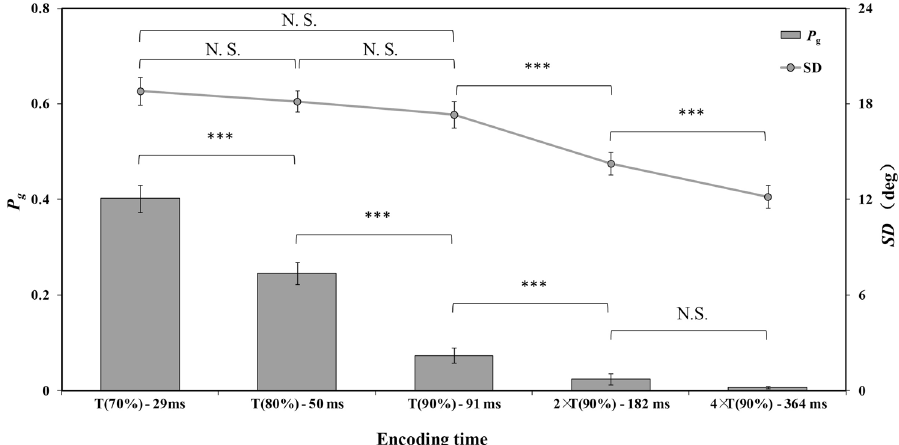
Figure 4. The mean precision parameter (SD) and guess-rate parameter (Pg) for each encoding time condition in Experiment 1. The abscissa axis represents the average encoding time of all participants in each condition. The error bars represent standard error. *** p < .001; N.S.